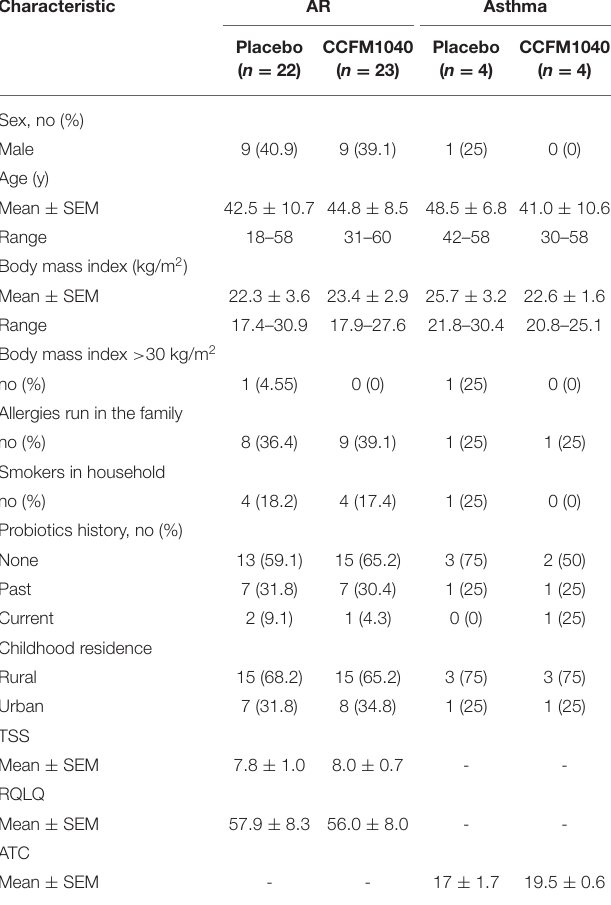
TABLE 1 | Demographic